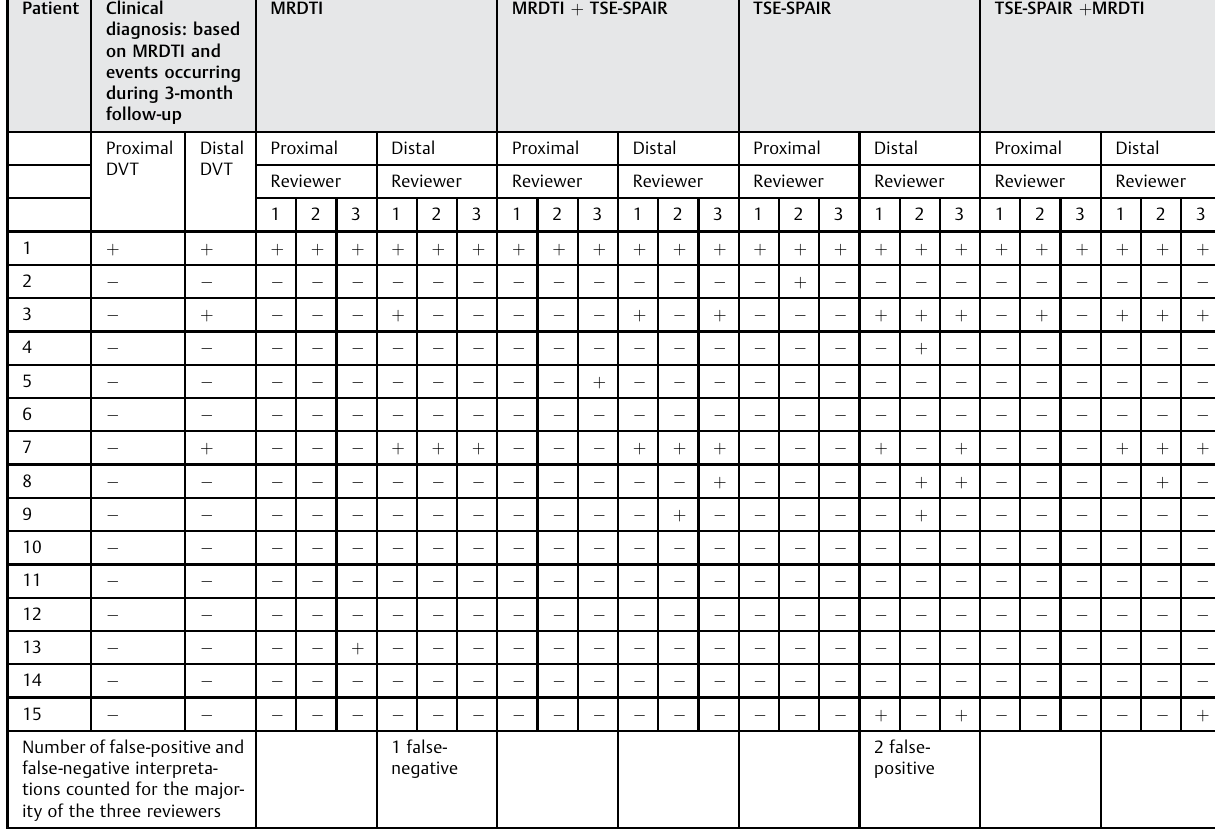
Table 2 Diagnosis and number of false-positive or false-negative cases for the majority of the three reviewers Patient Clinical diagnosis: based on MRDTI and events occurring during 3-month